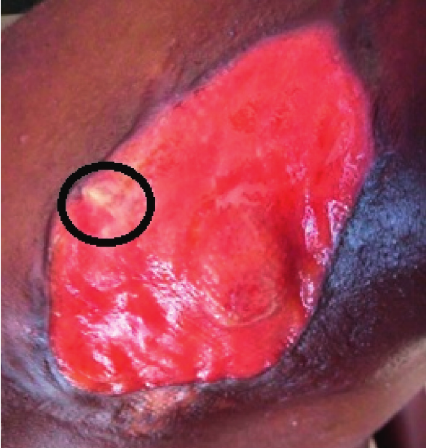
Figure 4: Protrusion of clavicular fracture end from the ulcer